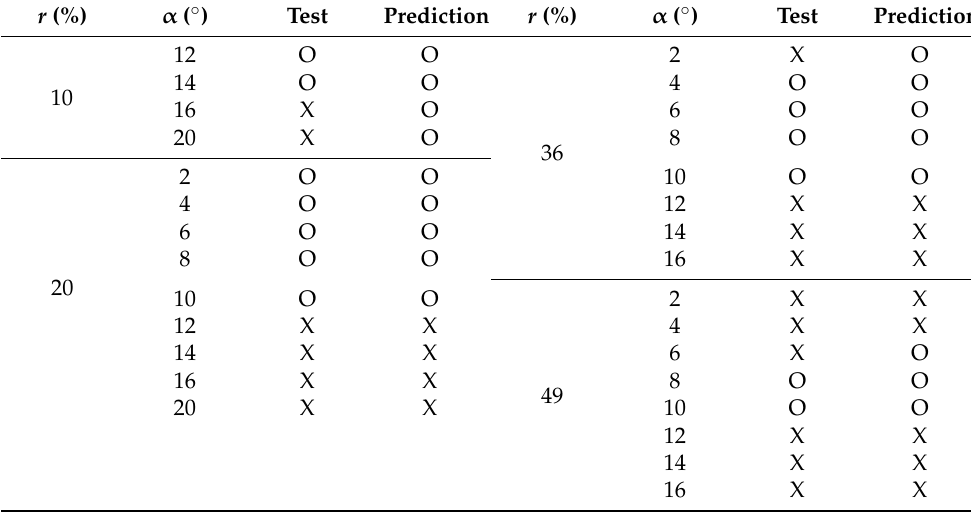
Table 4. Results of the draw bench test and the corresponding finite element (FE) analysis results, where “O” denotes no material fractured and “X” indicates material fracture occurred during